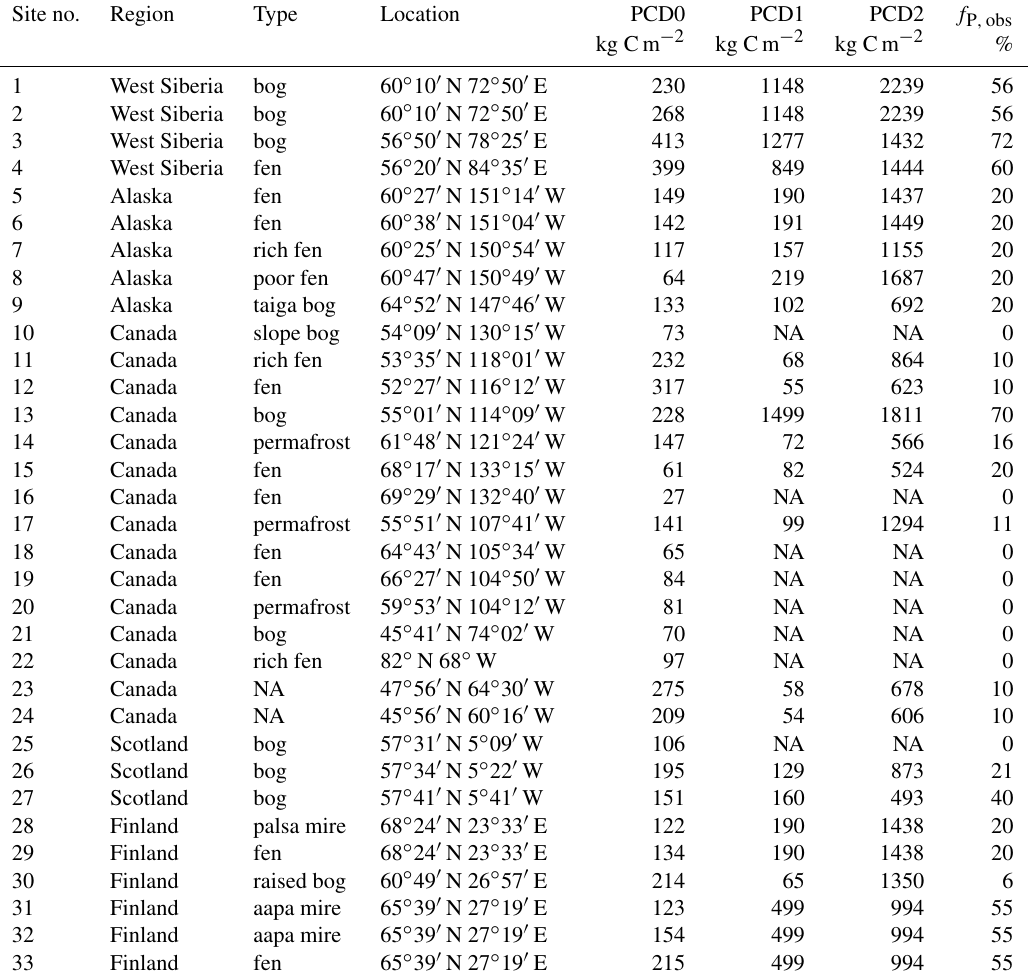
Table 1. Potential peat carbon density in the central part of peatland estimated under uniform (PCD1) and clumped (PCD2) interpretation of f P , obs , as compared to the observed peat carbon density (PCD0) at 33 peatland sites (Yu et al., 2009). Site